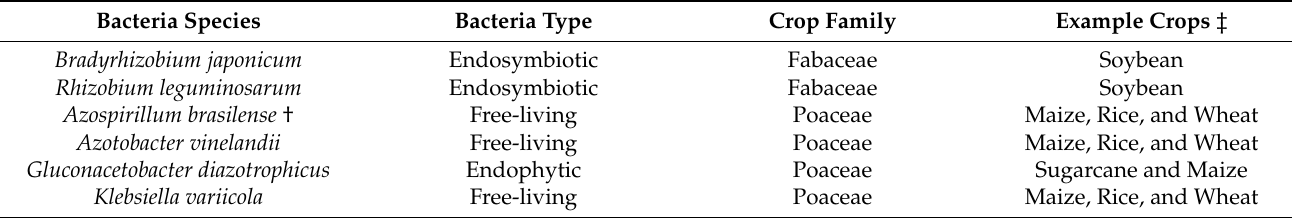
Table 3. Common bacteria known to fix nitrogen and that are often cultivated and utilized as biostimulants and some example corresponding crops that they are used